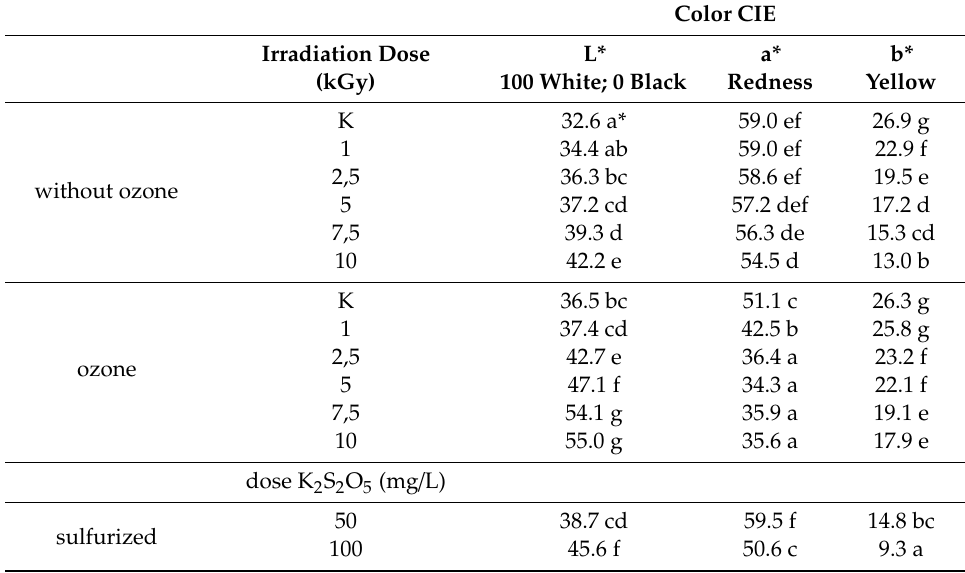
Table 2. Changes in the color of wine under the influence of ozonation (5 min), irradiation, and sulphurization.